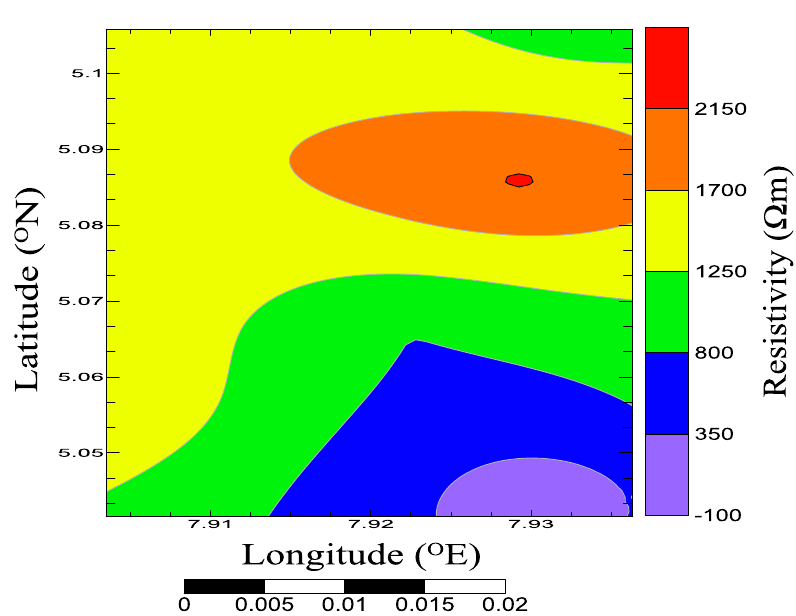
Fig. 3 Contour map showing the distribution of aquifer